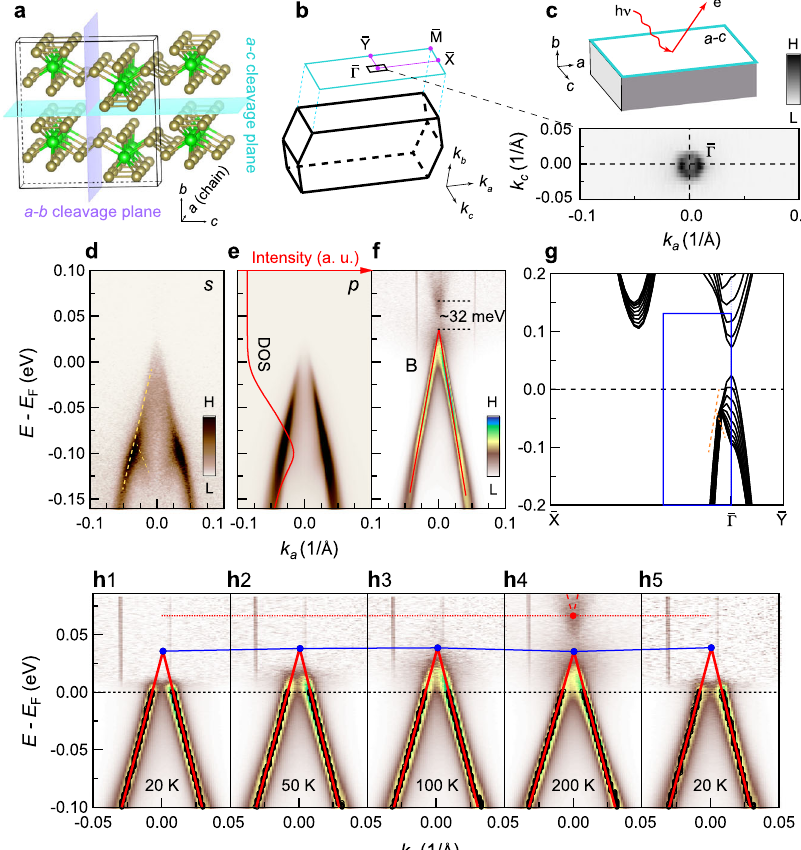
Fig. 1 Band structure of the top a-c surface. a Crystal structure of ZrTe 5 and its cleavage planes. b The bulk Brillouin zone (BZ) and its projected surface BZ on the top a-c surface. c Fermi surface measured from the a-c surface, of which the range is indicated by the black box in b . d – e Band structure measured from the a-c surface with s and p -polarized light at 200 K, respectively. Light-yellow dashed lines in d highlight the band splitting around − 0.1 eV. The red line in e shows the density of states (DOS). f Same as e , but normalized with its DOS for a clear presentation of the conduction band above Fermi level ( E F ), which will not affect the MDC peak positions. Details of the normalization can be found in Supplementary Fig. 2. g Band structure from fi rst- principles slab calculations on the a-c surface. The blue box roughly indicates the momentum range in d – f . Orange dashed lines highlight the splitting similar to the one in d . h Temperature dependence of the band structure taken with p -polarized light. The black markers are extracted from MDC peaks, and the red solid lines are the fi tting results of the black markers. The blue line with solid markers indicates the top of the valence band at different temperatures. The red dashed line marks the conductance band bottom at 200 K. Details of the band fi tting can be found in “ Methods ” calculated Fermi surface (Fig. 2j) displays four sheets: two open sheets (red color) and two closed sheets (black color). By